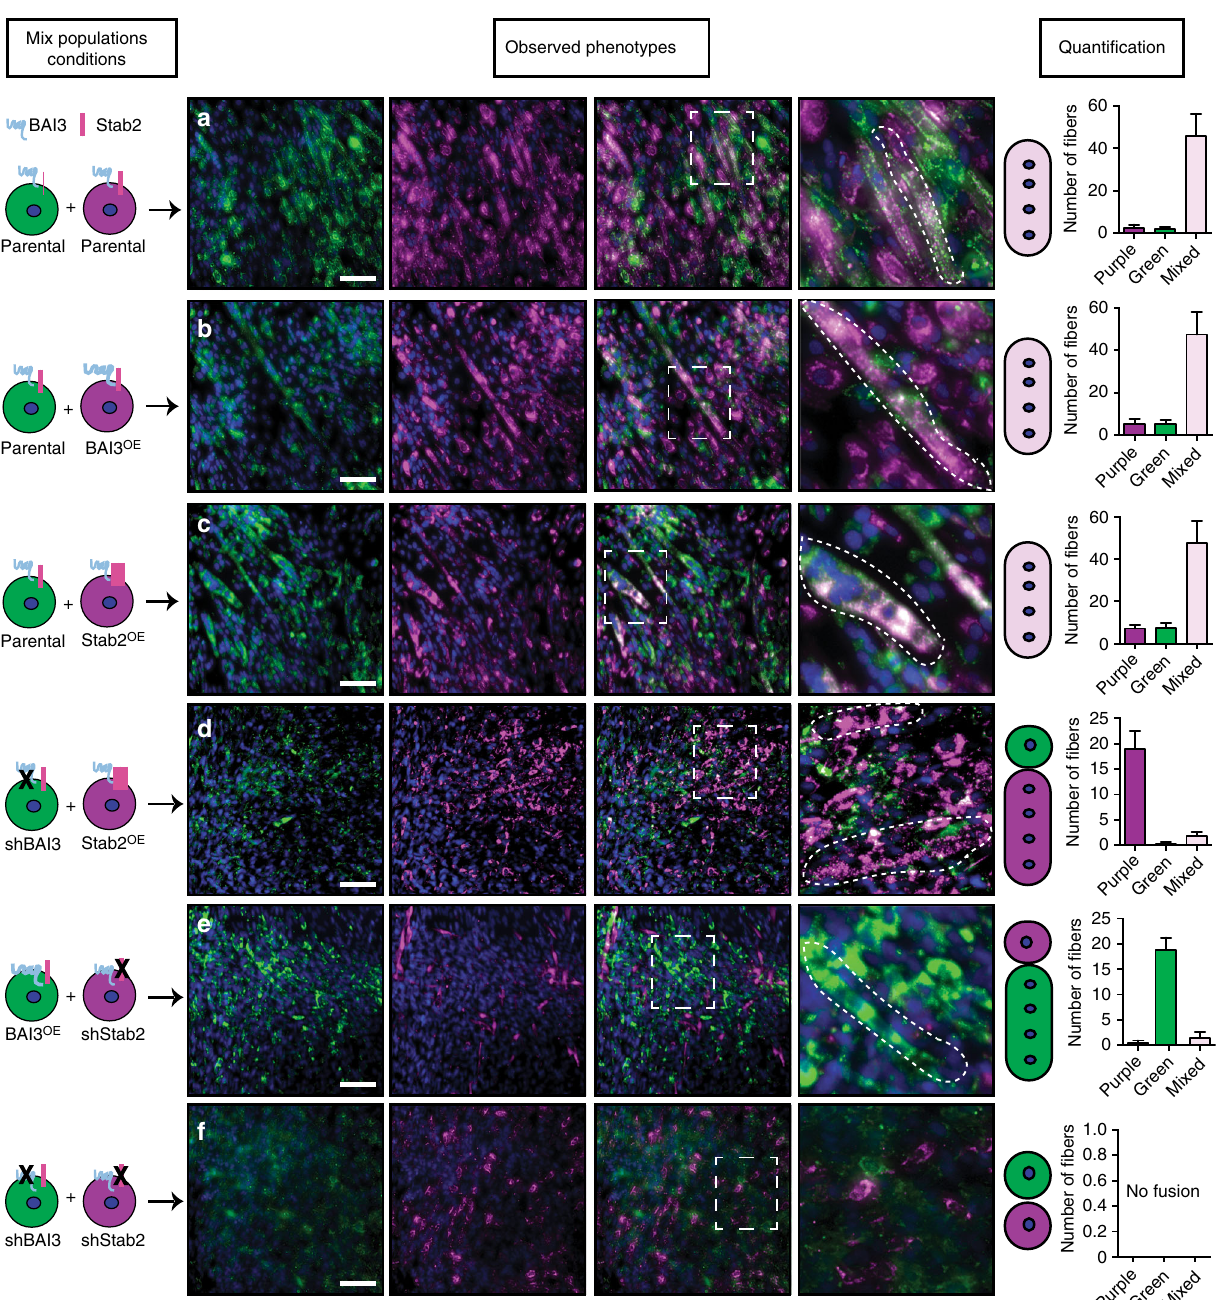
Fig. 6 BAI3 and Stabilin-2 interact in cis in myoblasts to promote cell fusion. Stabilin-2 and BAI3 are required on the same myoblast to promote cell fusion. a Parental C2C12 cells were stained with membrane dyes and mixed in a 1:1 ratio. 24 h after plating, cells were switched into differentiation conditions for 48 h. b Parental C2C12 mixed with C2C12 overexpressing Flag-BAI3. c Parental C2C12 (green) mixed with C2C12 overexpressing V5-Stabilin-2 (purple). Cell fusion was intact and mixed fi bers were observed after differentiation. d C2C12-expressing shRNA against BAI3 (green) are mixed with C2C12 overexpressing Stabilin-2 (purple). Cells without BAI3 were unable to fuse and mix with other population after differentiation. e C2C12 expressing shRNA against Stabilin-2 (purple) were mixed with C2C12 overexpressing BAI3 (green). Mixed fi bers were not observed and only cells expressing both receptors were able to fuse together after differentiation. f Cells-expressing shRNA against Stabilin-2 or BAI3 were mixed and no fusion was observed following differentiation. The quanti fi cation of the phenotypes was analyzed from multiple images. Scale bar = 100 μ Elmo2 interacts with G-proteins 42,44 . Elmo2 did not affect the Elmo proteins are effectors of G α i and G βγ 42,43 . BAI3-mediated activation of G α i and G βγ could contribute to recruit Elmo to coupling of G α i2 , G α i3 or G α 12 to GFP10-G γ 2 (Fig. 7d). We BAI3 to promote fusion. We tested whether Elmo2 can interact explored whether the GPCR activity of BAI3 may facilitate the with G α i or G βγ subunits in living cells. When we expressed Myc- recruitment of Elmo2 to the membrane. We found that Myc- Elmo2 was distributed in the cytosol when expressed alone or Elmo2, we found that the basal BRET2 signal from RlucII-tagged expressed with BAI3 WT in C2C12 (Fig. 7e, f) or COS7 G α i1 and GFP10-tagged G γ 2 decreased (Fig. 7d), indicative that